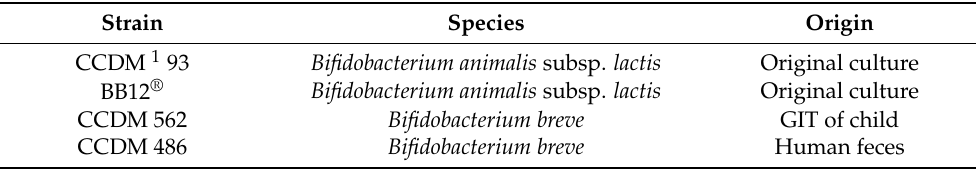
Table 1. Selected